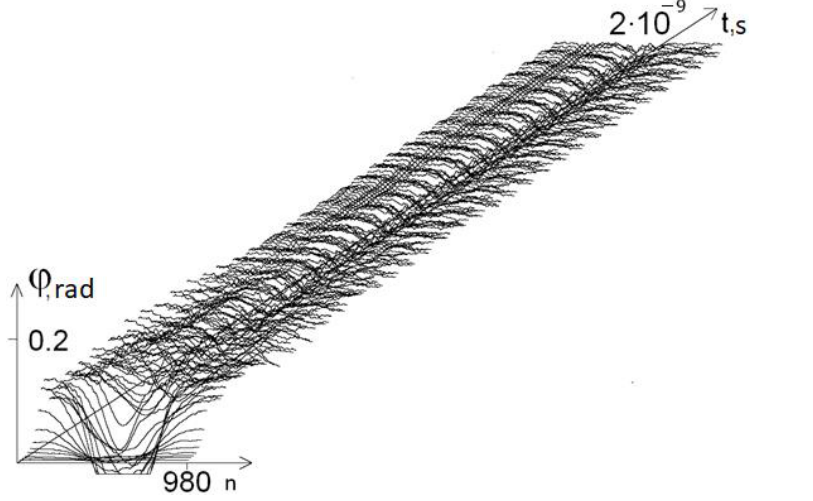
Figure 3. Graph of the angular deviations of the first DNA chain with 40A substitution at ω = 10 11 s – 1 .